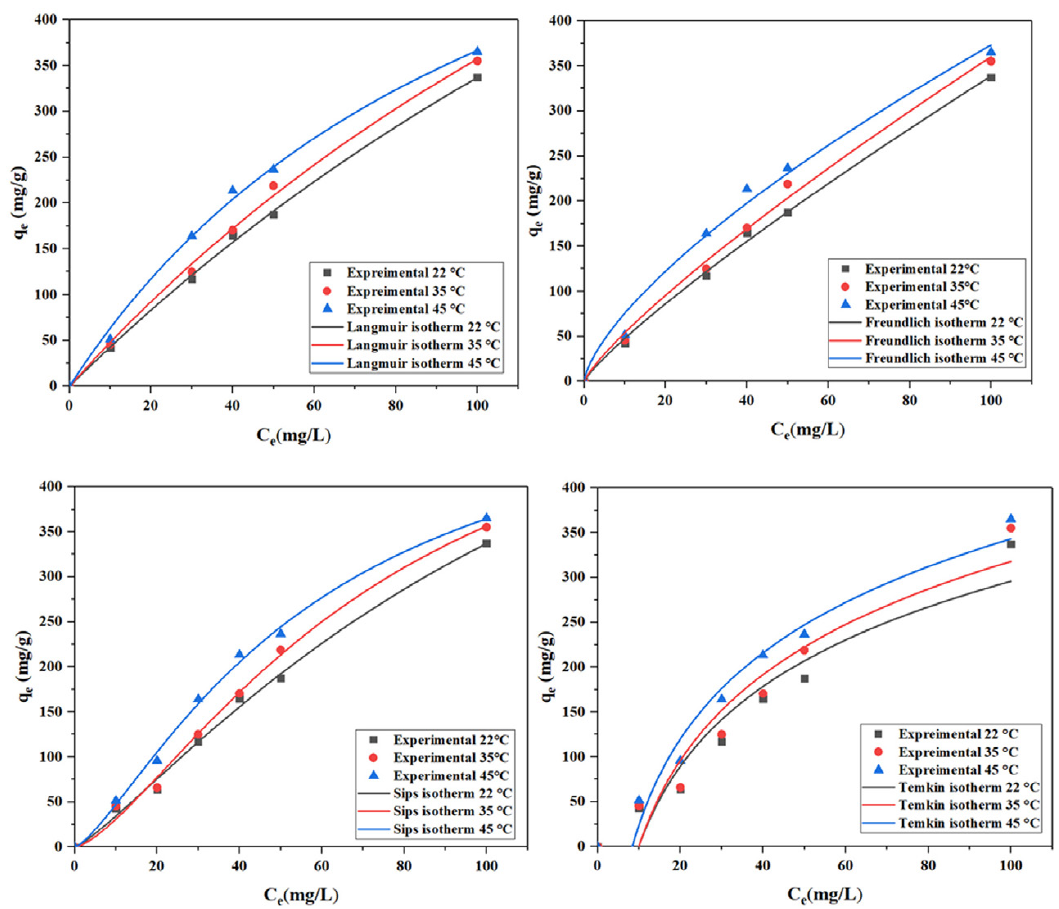
Fig. 11. Langmuir, Freundlich, Sips, and Temkin isotherm models for the adsorption of Pb(II) onto modified pectin/ γ -Fe